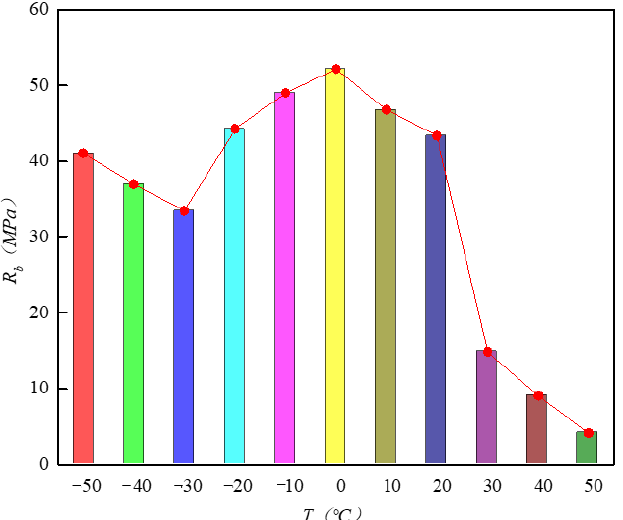
Figure 20. Flexural tensile strength of polyurethane cement at different temperature